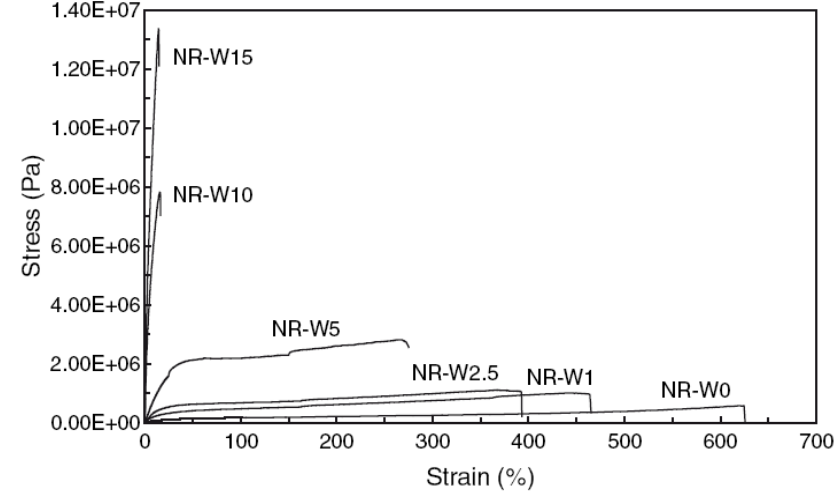
Figure 9. Typical stress-strain curves obtained from tensile tests (T = 25 °C) for natural rubber (NR) reinforced with cellulose date palm tree whiskers (W). The number in the codification of the sample corresponds to the whiskers content (wt%)